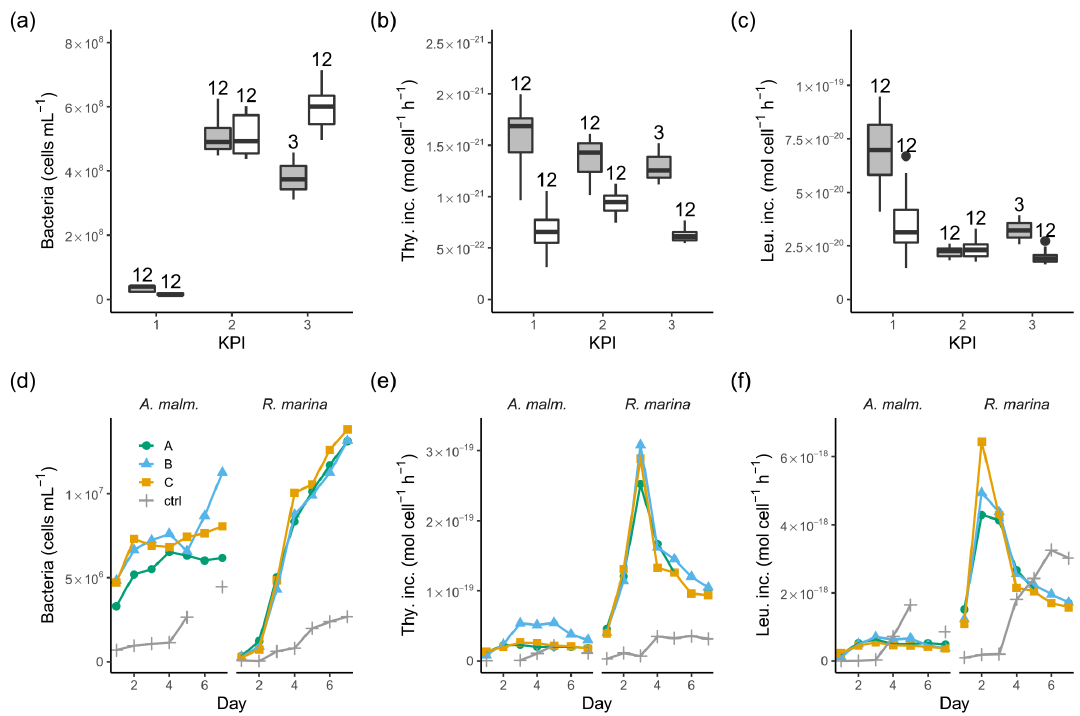
Figure 4. Bacterial abundance (a, d) , cell-specific bacterial thymidine (b, e) , and leucine (c, f) incorporation at each KPI (0–12h measure- ments pooled) in the DOM release experiment (boxplots) and in the DOM consumption experiment (line graphs). Lines A, B, and C mark different replicates (culture filtrate + seawater bacteria), and ctrl marks the control (F/2 + seawater bacteria). The number above the boxplots shows the number of measurements. Lower and upper hinges of boxes mark the first and third quartiles, respectively, while the whiskers extend to the lowest and the highest values within 1.5 times the interquartile range. Grey boxes (left) show A. malmogiense , and white boxes (right) show R. marina . Due to a measurement error only 12h measurements of bacterial abundance are available in A. malmogiense treatments at the third